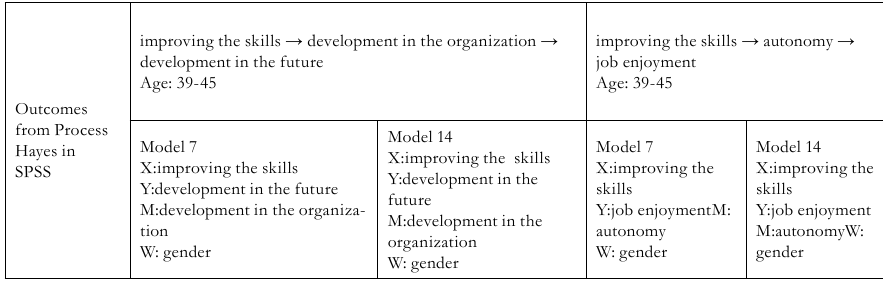
Outcomes from Process Hayes in